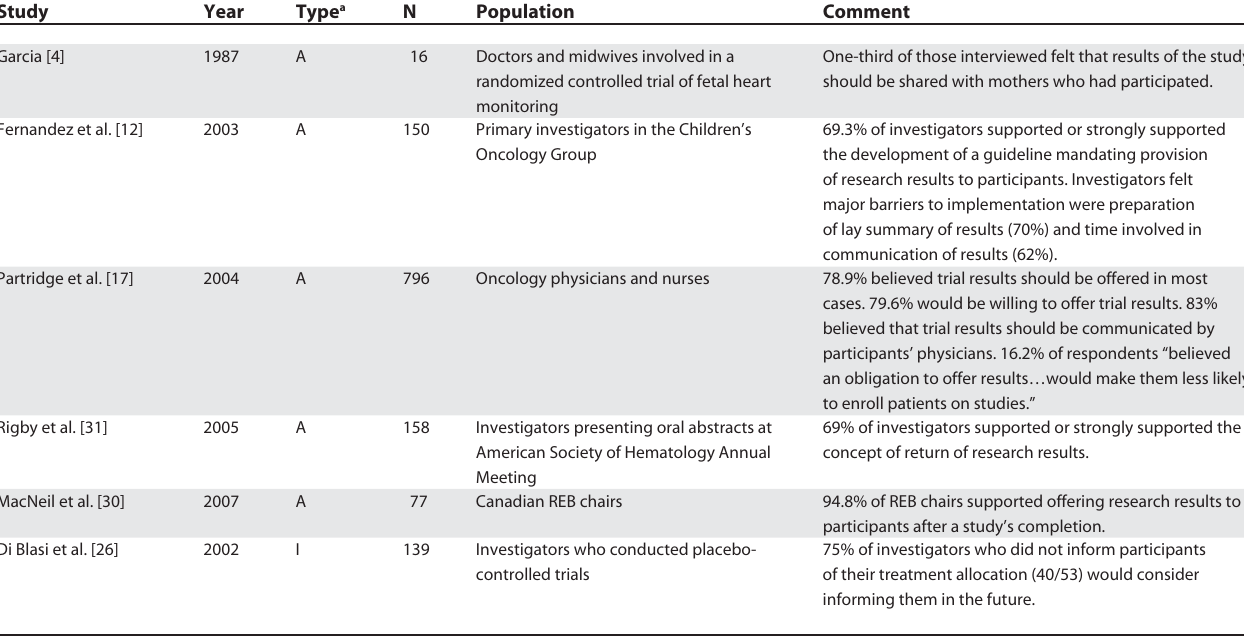
Table 2. Investigators’ Support for Communicating Research Results